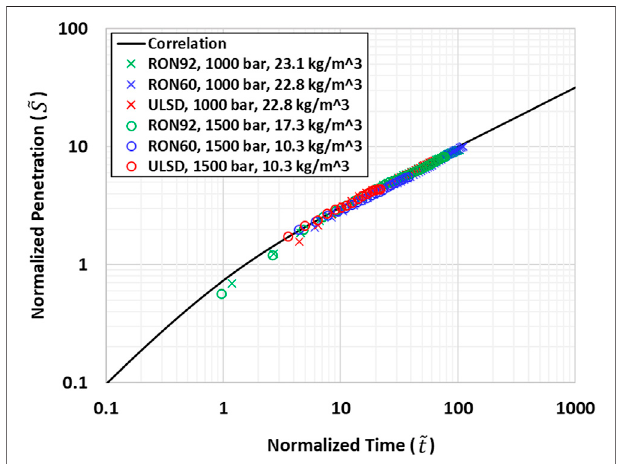
FIGURE 18 | Normalized spray penetration curves for non-vaporizing data set.